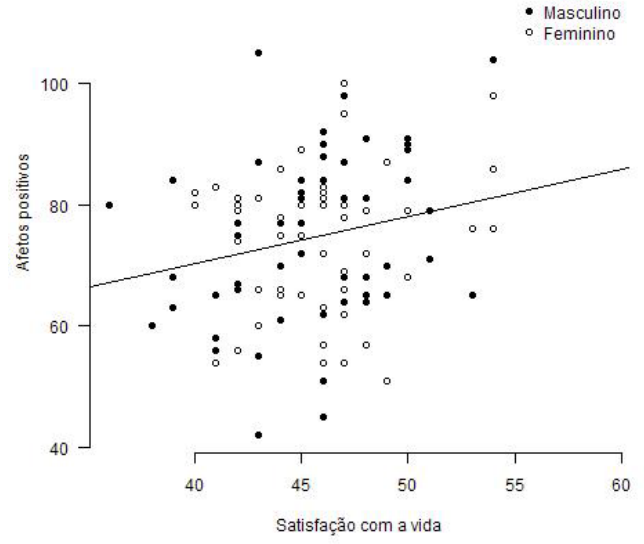
Figura 2 . Correlação entre afetos positivos e satisfação com a vida ( N